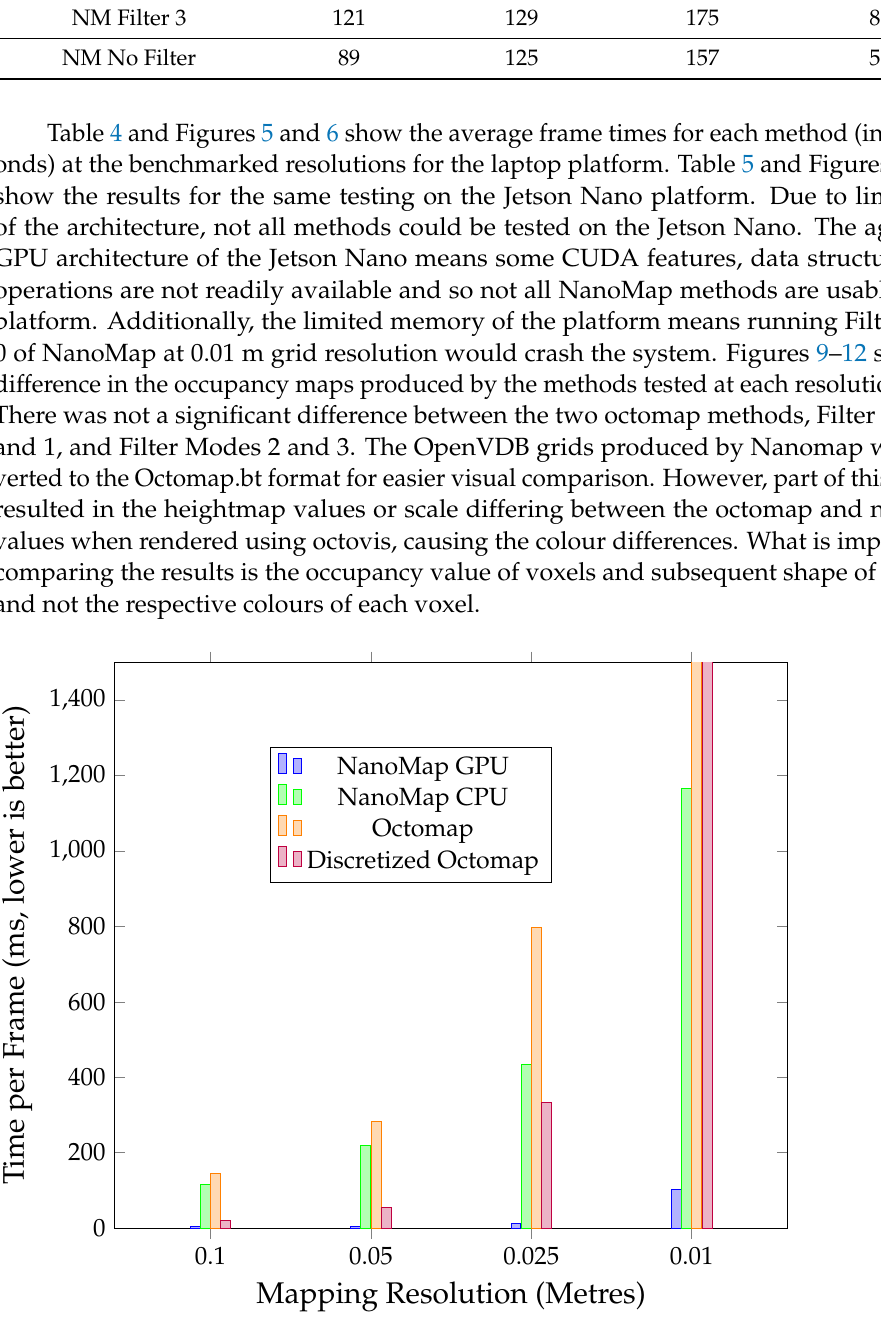
Figure 5. Asus Zephyrus G14 NanoMap GPU vs. CPU performance (see Figure